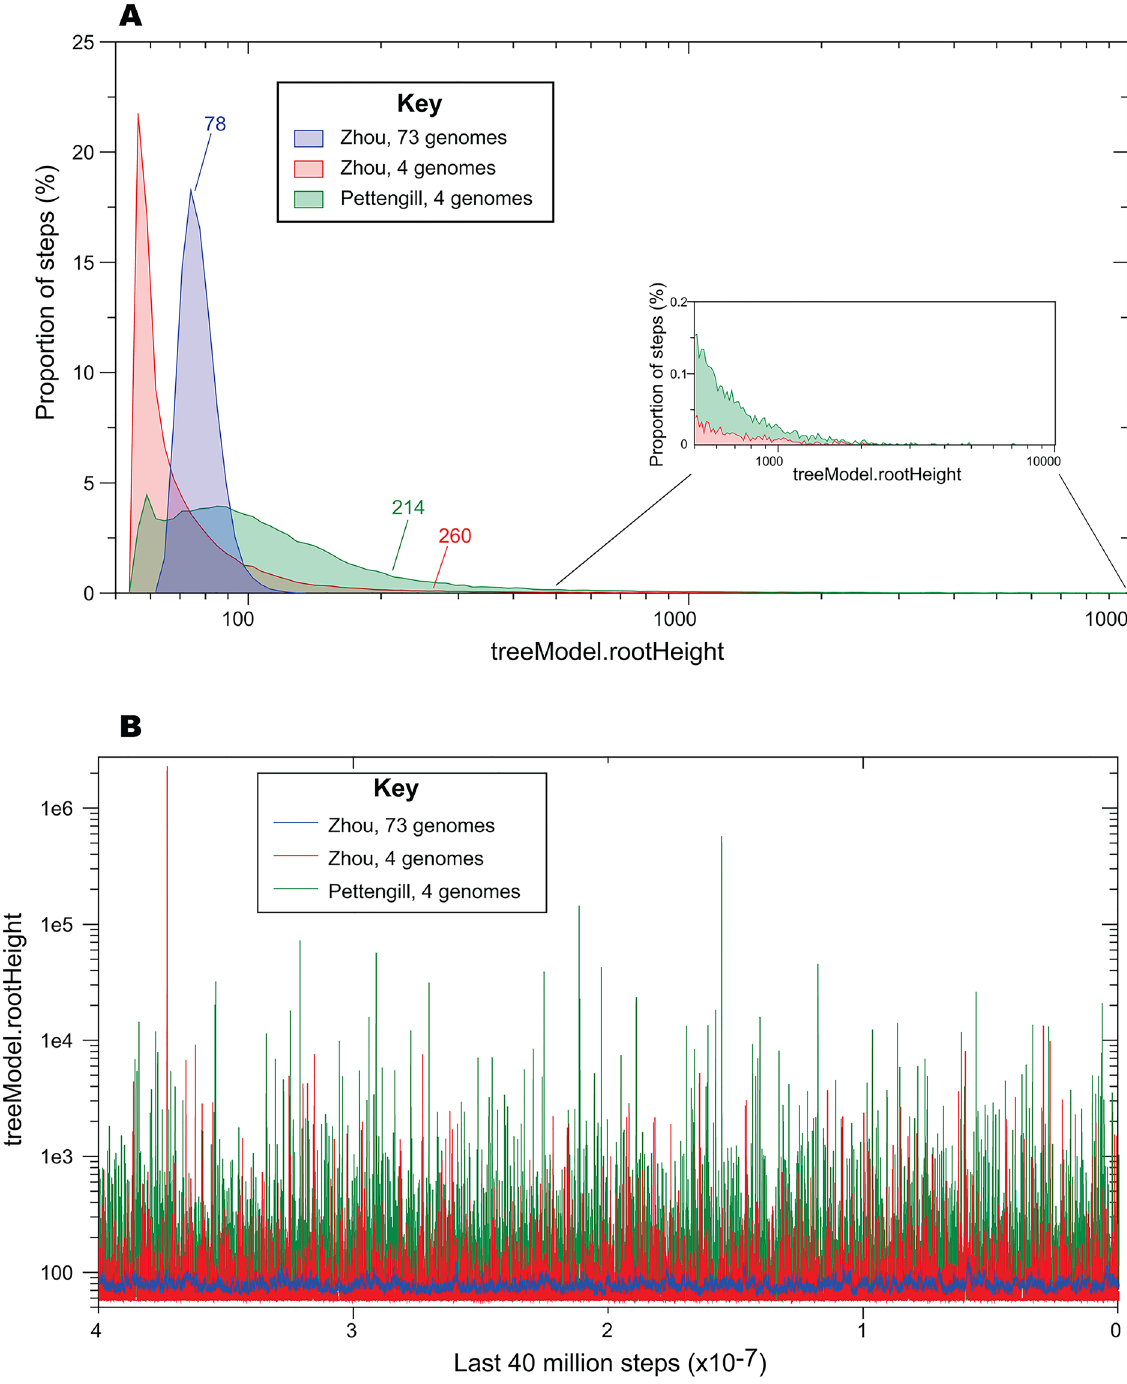
Fig 2. Comparisons of treeModel.rootHeight estimates by BEAST with different SNP calls and different numbers of genomes. A. Distribution of numbers of estimates of rootHeight as a percentage of all estimates in BEAST analyses according to the best model in Table 1. The numbers were from samples taken every 1000 steps over a total of 200 million steps (4 genomes) or 50 million steps (73 genomes), after excluding the first 10 million steps as burn-in. Mean values of rootHeight are indicated next to arrows. Inset, different scale for values of rootHeight over 500 years. B. Representation of the individual rootHeight values for each sample over the last 40 million steps. Pettengill, 4 genomes: uses the SNP calls calculated by Pettingill [15]; Zhou, 4 genomes: uses the SNP calls for the same four genomes extracted from the core genomes in Zhou et al ., [9]; Zhou 73 genomes, uses the core genome SNPs from all 73 genomes in